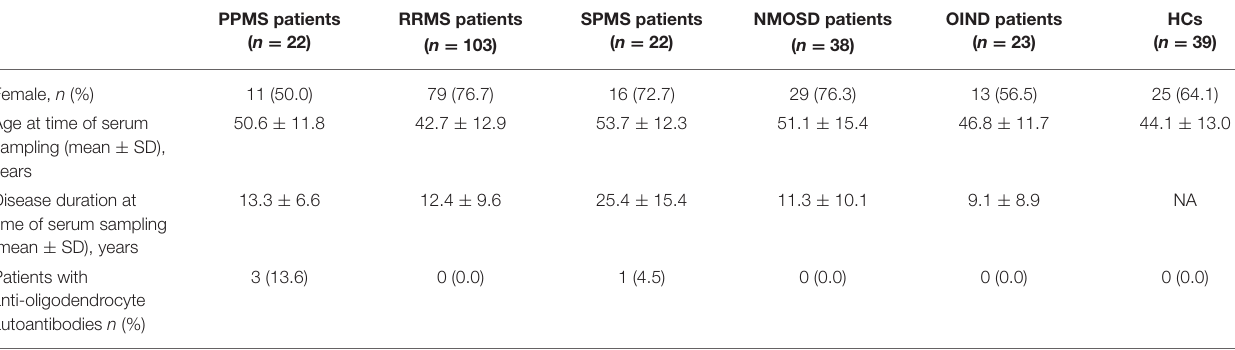
TABLE 1 | Demographics and anti-oligodendrocyte antibody status of the study